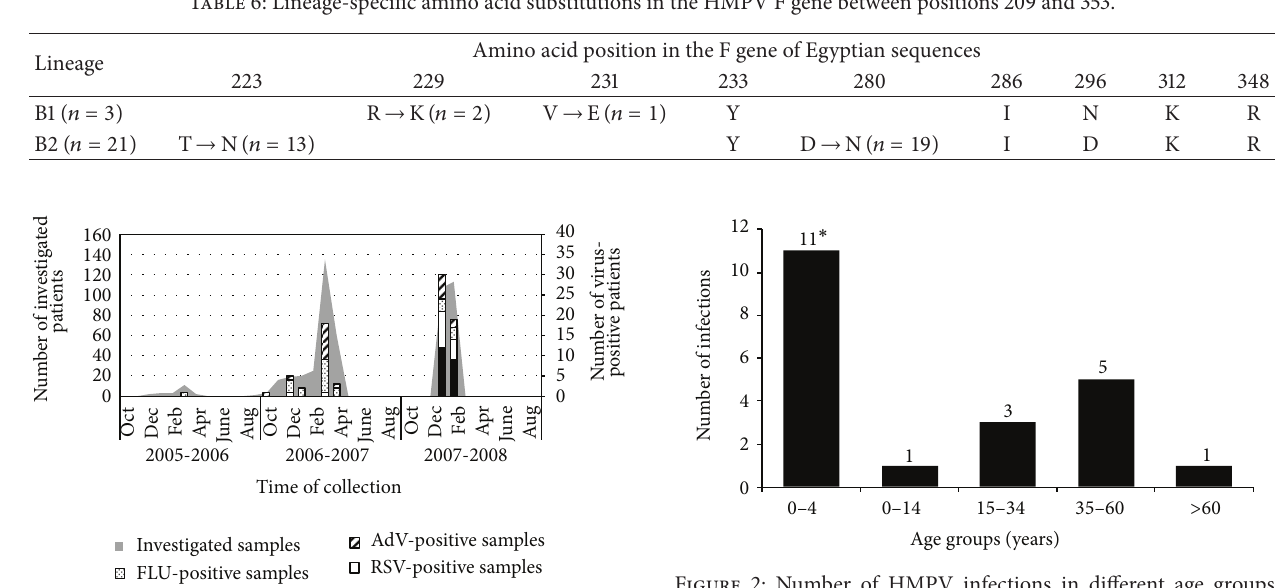
Figure 2: Number of HMPV infections in different age groups ( ∗ 𝑃 = 0.0001